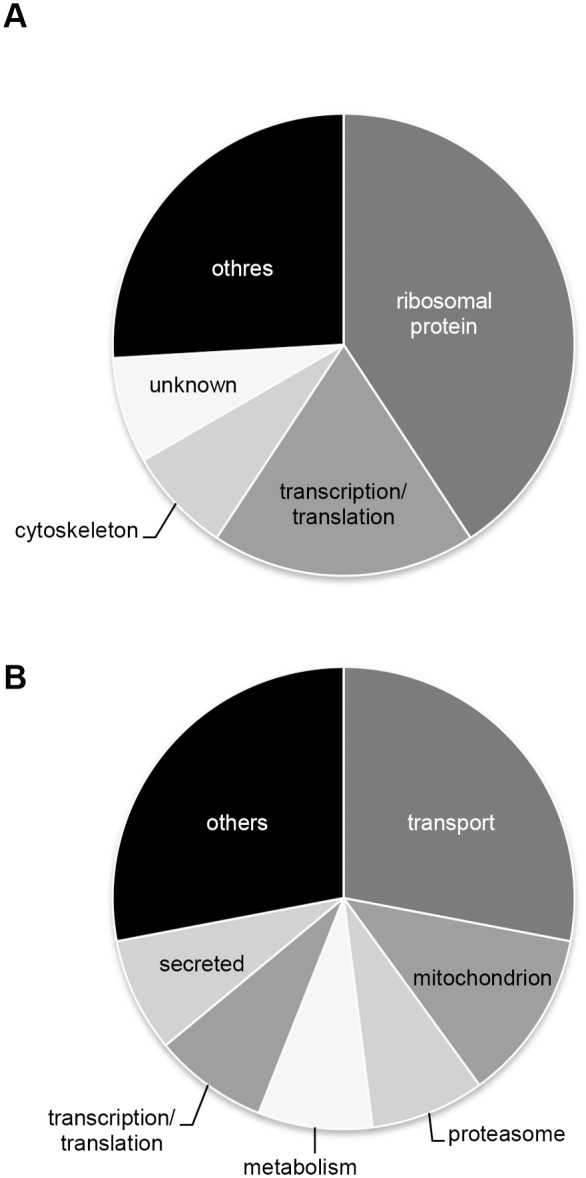
Functional annotation of upregulated or downregulated proteins in Rab1A knockdown cells.HT29 cells were transfected with siRNA for Rab1A or scramble control. Protein identification in Rab1A knockdown cells was performed through quantitative proteomics by stable isotope labeling, using iTRAQ. (A) Upregulated proteins with iTRAQ ratio ≥1.2. (B) Downregulated proteins with iTRAQ ratio <0.8.